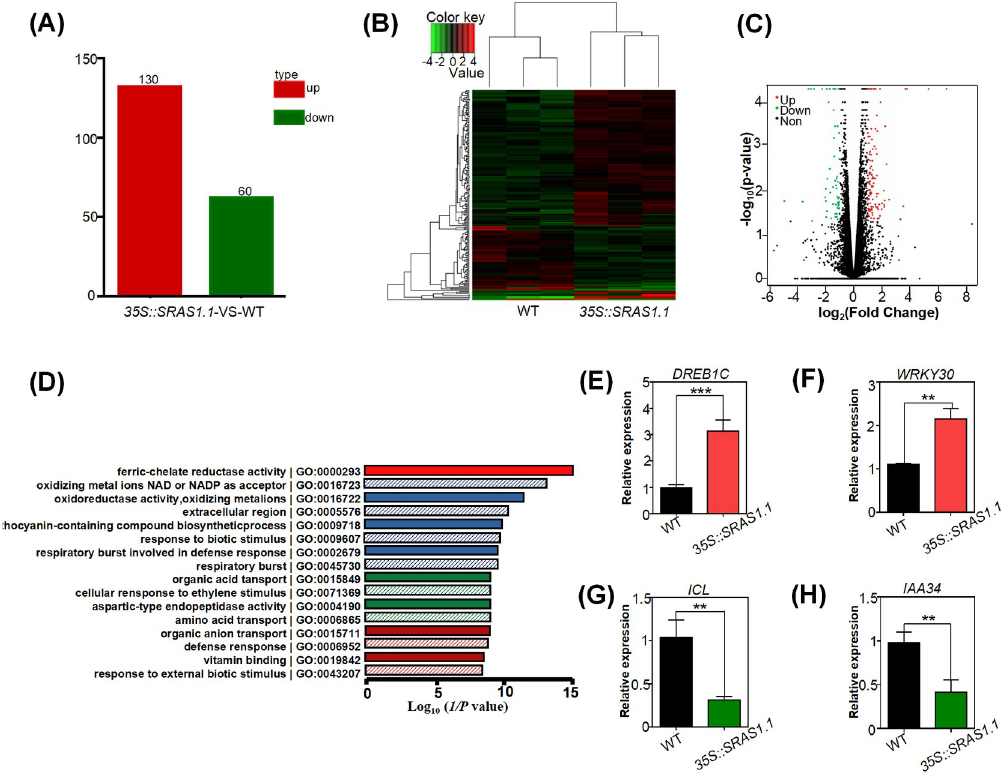
Fig 4. Genome-wide effects in 35S :: SRAS1 . 1 transgenic plants. (A) Differentially expressed genes in RNA-seq assay. The histogram depicts the total number of differentially expressed genes in 35S :: SRAS1 . 1 transgenic plants versus WT. Up- and down-regulated genes are shown in red and green bars, respectively. (B) Average linkage hierarchical clustering analysis of differentially expressed genes, with three repeated samples. (C) Scatter plots of genes in WT and 35S :: SRAS1 . 1 . Red dots represent up-regulated genes, green dots represent down-regulated genes and black dots represent no significant difference genes. (D) GO function significant enrichment analysis. The log 10 (1/P) values represent the enrichment ratio of members of the specific GO terms. (E)-(G) qRT-PCR analysis of the expression levels of marker genes involved salt response pathways. Data are represented as means ± SD, n = 6. ( �� P < 0.01, ��� P < 0.001).